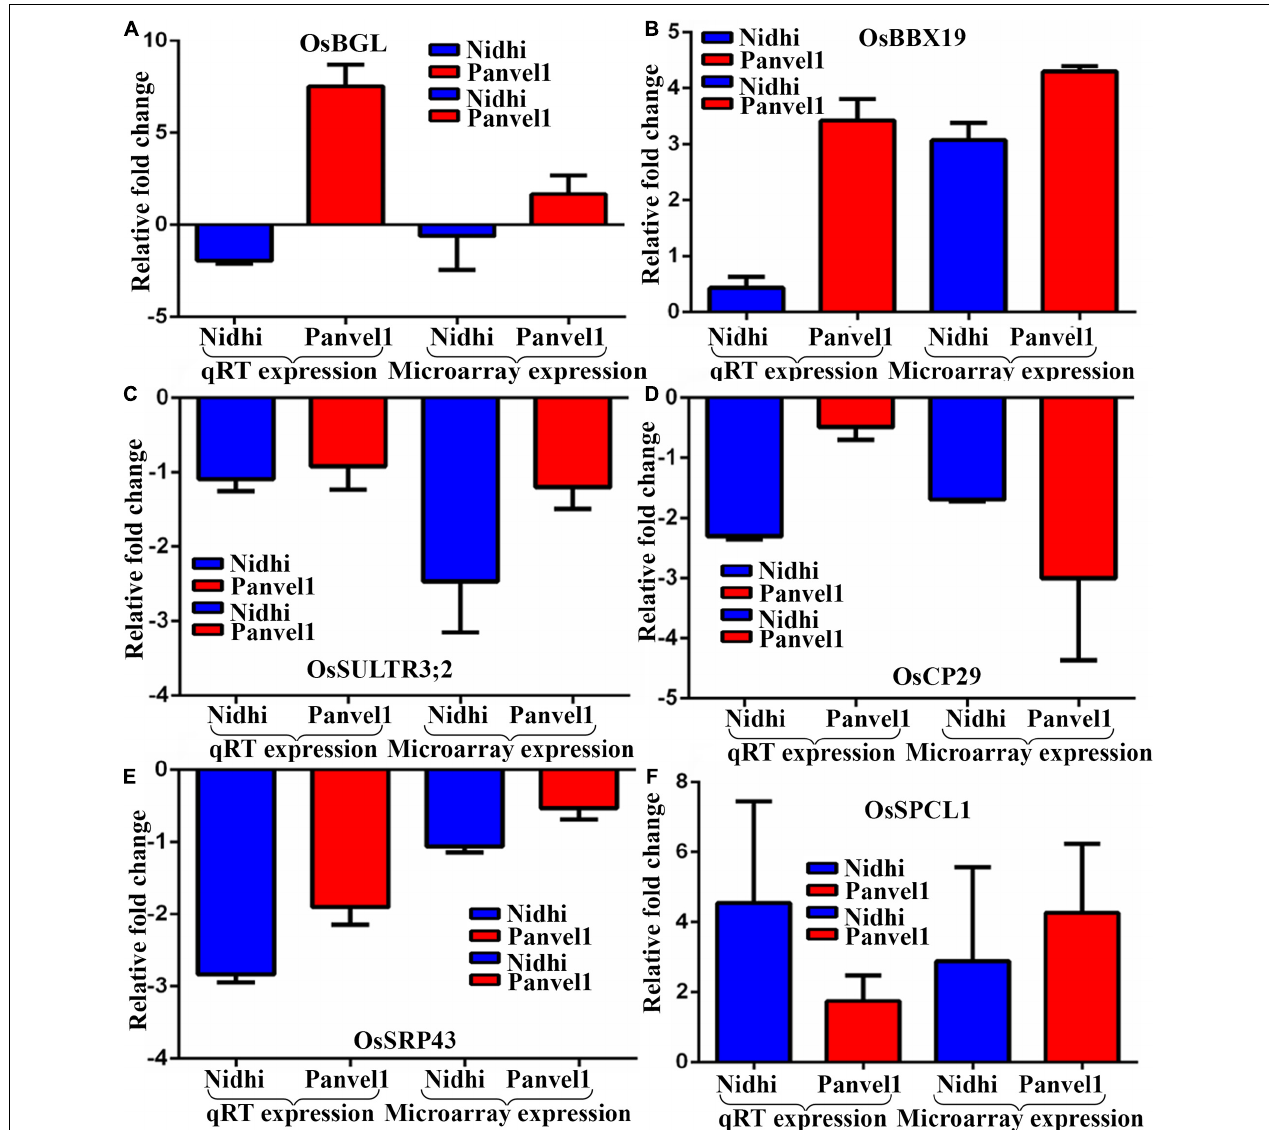
FIGURE 3 | Validation of expression profile of nitrate responsive genes by RT-qPCR. Relative change in the gene expression was calculated by the comparative Ct value method and the actin gene was used for data normalization. The control values were taken as zero and the test values are shown as the average of three technical and two independent biological replicates (+SE) except gene BGL1 for which the calculations were done based on three technical replicates of a biological replicate. Each sub-figure compares gene expression of RT-qPCR and microarray for Nidhi versus Panvel1 for gene OsBGl1 (A) , OSBBX19 (B) , OsSULTR3;2 (C) , OsCP29 (D) , OsSRP43 (E) , and OsPCL1 (F)